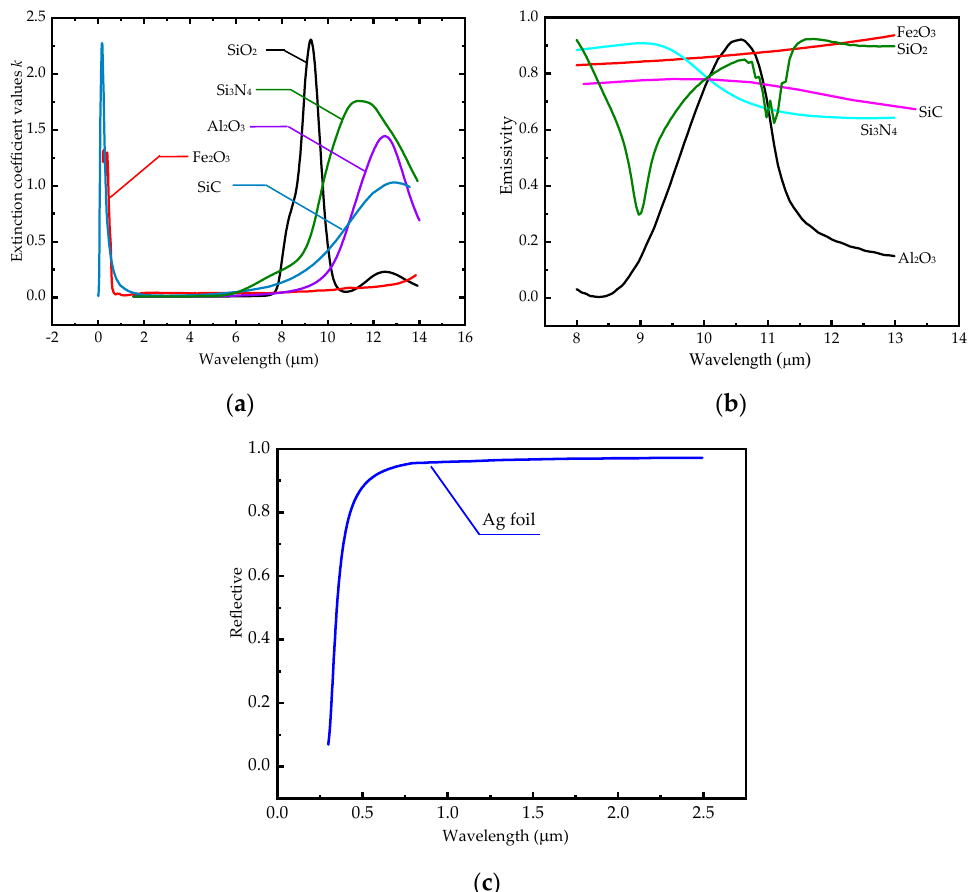
Figure 5. Properties of different materials. ( a ) Extinction coefficients of different materials; ( b ) emissivity of different materials at atmospheric window bands; ( c ) reflectance of Ag foil in the band 0.3–2.5 μ m.